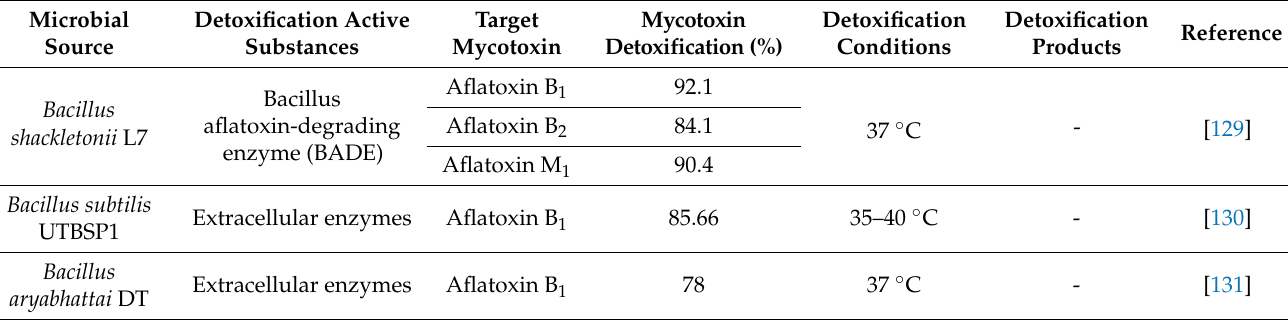
Table 4. Sources of active microbial substances that detoxify mycotoxins and their conditions of